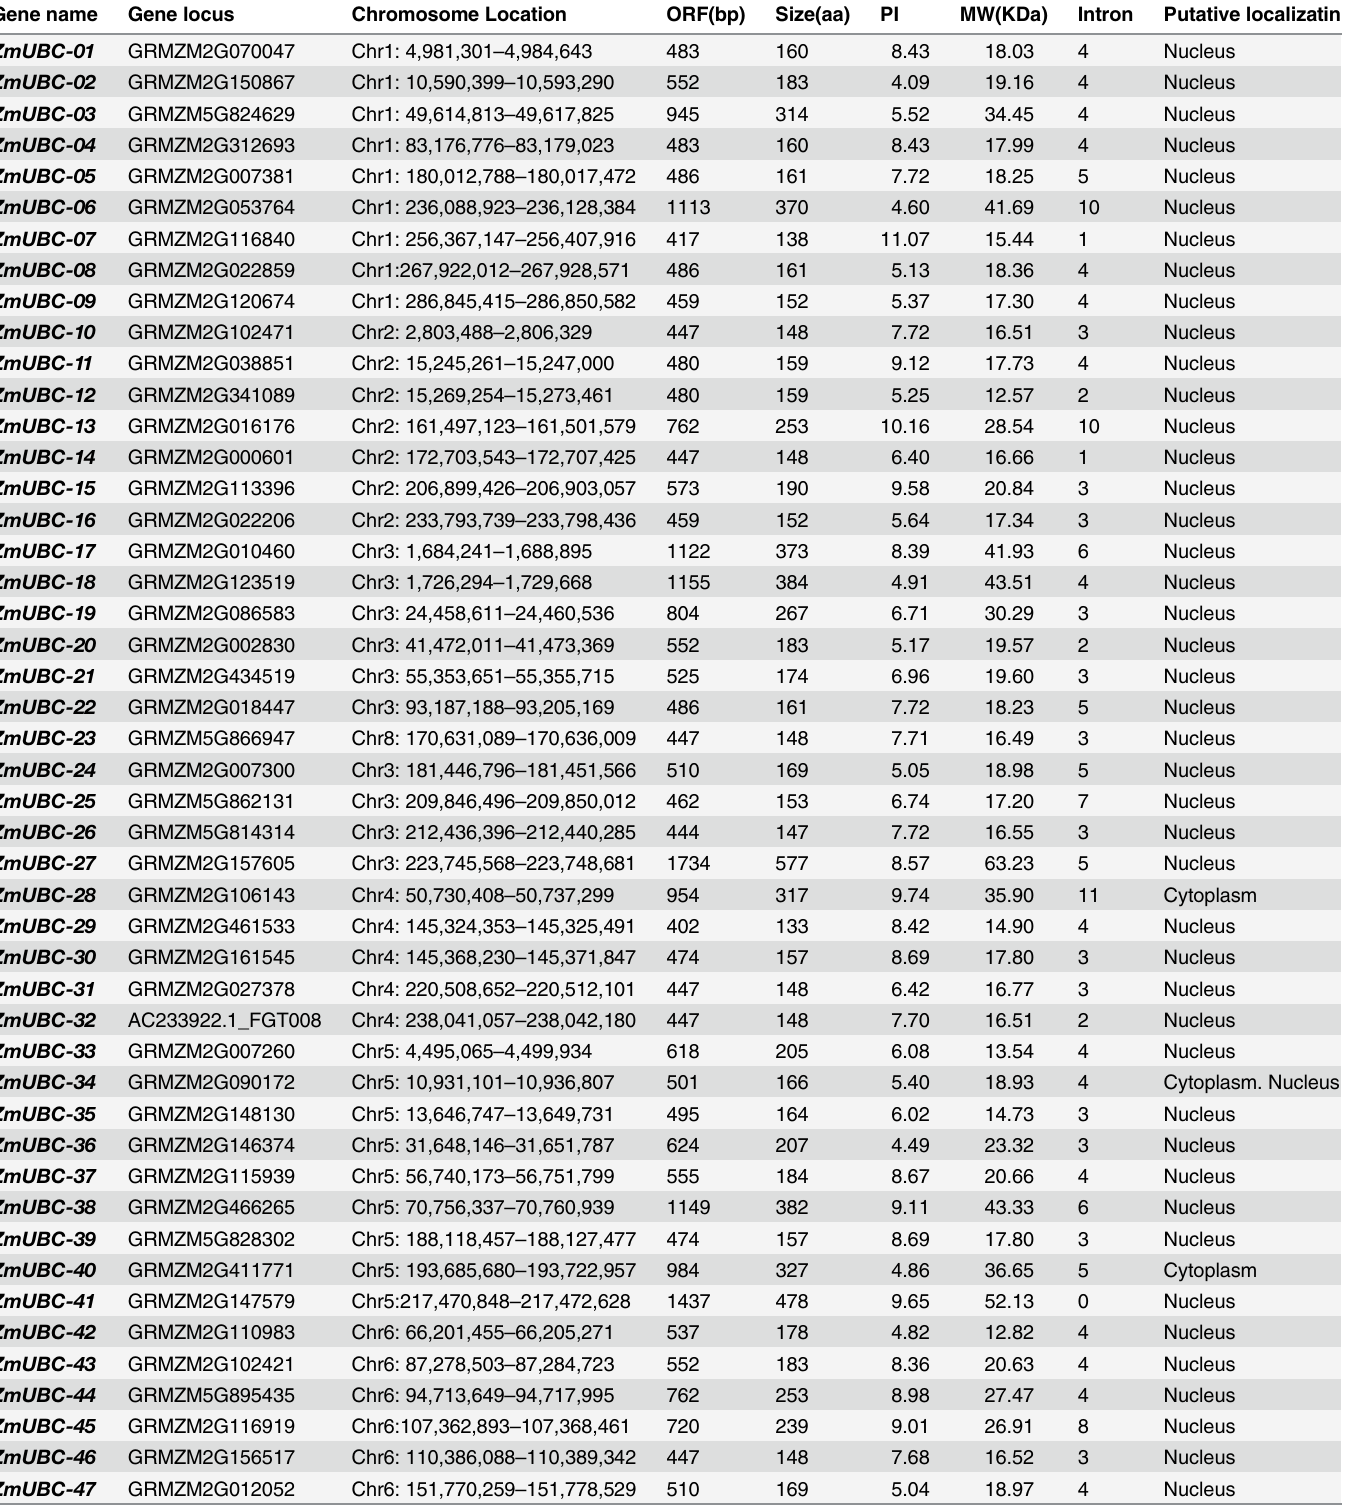
Table 1. The information of ZmE2 gene